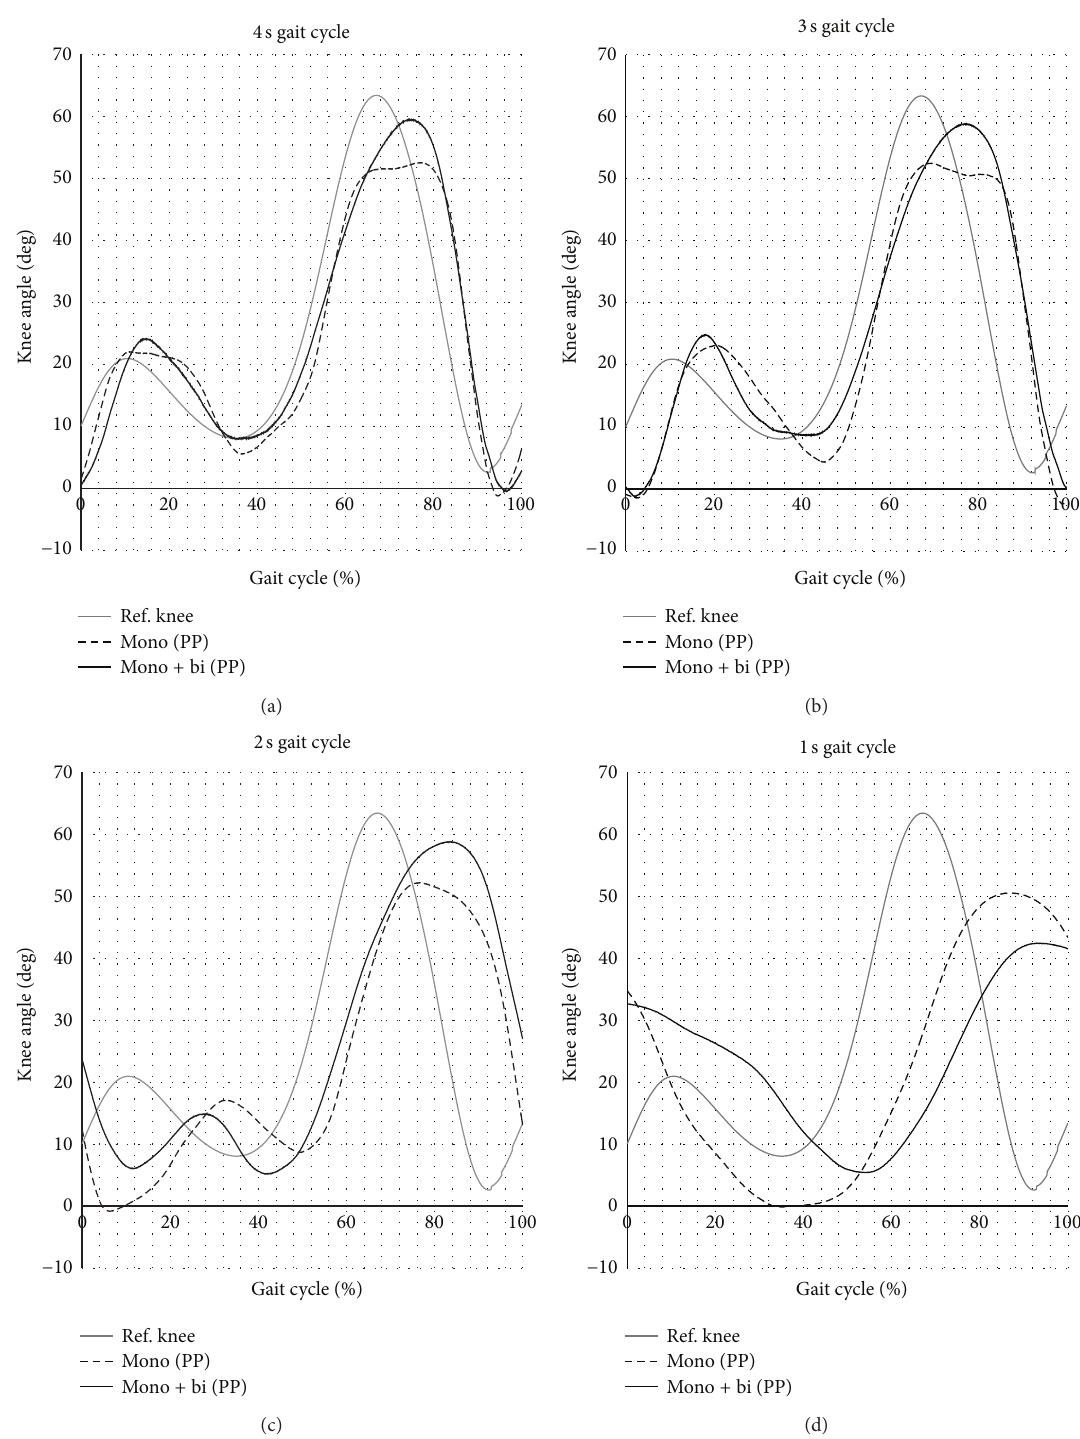
Figure 10: Knee joint trajectory for the control of the leg orthosis WO/S using a cocontraction model based PP controller.